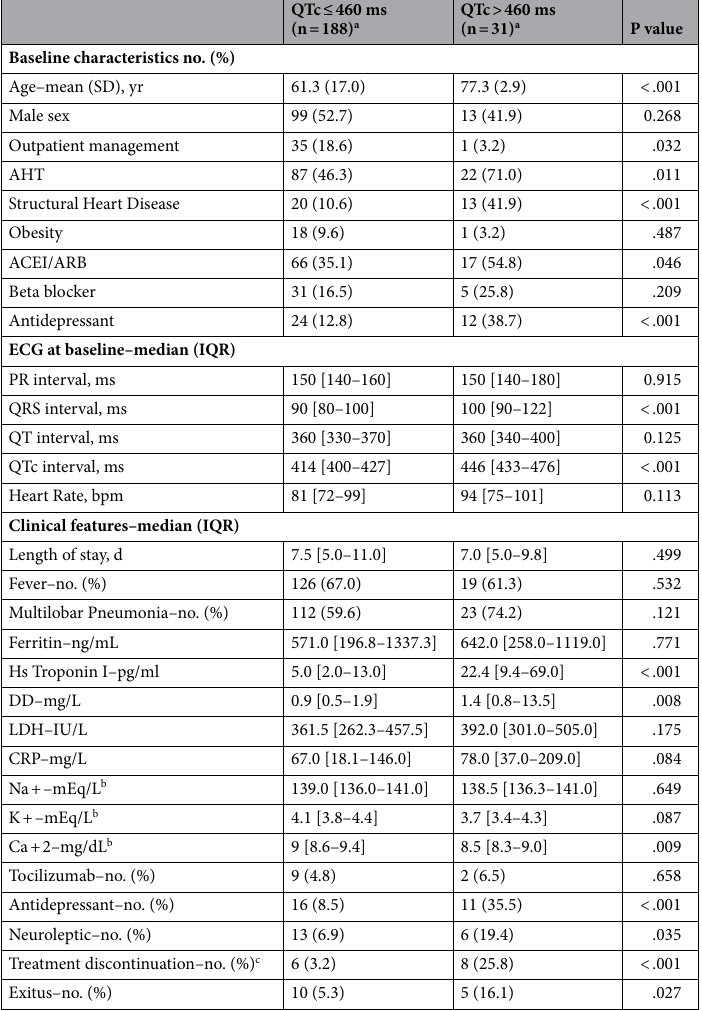
Table 2. Baseline, ECG and clinical characteristics of patients according to the QTc interval at ≥ 48 h from treatment initiation. ACEI, angiotensin converting enzyme inhibitor; AHT, arterial hypertension ARB, angiotensin receptor blocker; CRP, C-reactive protein; DD, D-dimer; ECG, electrocardiogram; Hs, high sensitive; IQR, interquartile range; LDH, lactate dehydrogenase; SD, standard deviation. a Both groups were created using a QTc cut-off of 460 ms in the ECG at ≥ 48 h from treatment initiation. b Plasma ions were analyzed at the time the control ECG was performed. c Treatment discontinuation because of findings in the ECG at ≥ 48 h from treatment